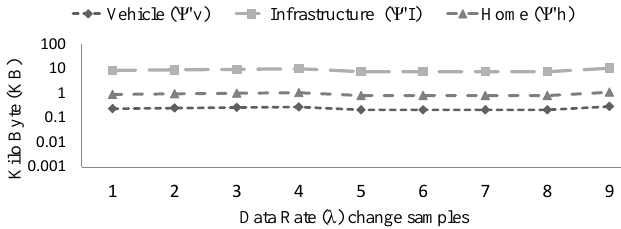
Figure 12. Comparing the storage requirements of vehicle, infrastructure and home on the change of data rate ( λ ). From sample 5 to 8, safety information is not stored. Y-axis is measured in log scale of base 10 (thousands